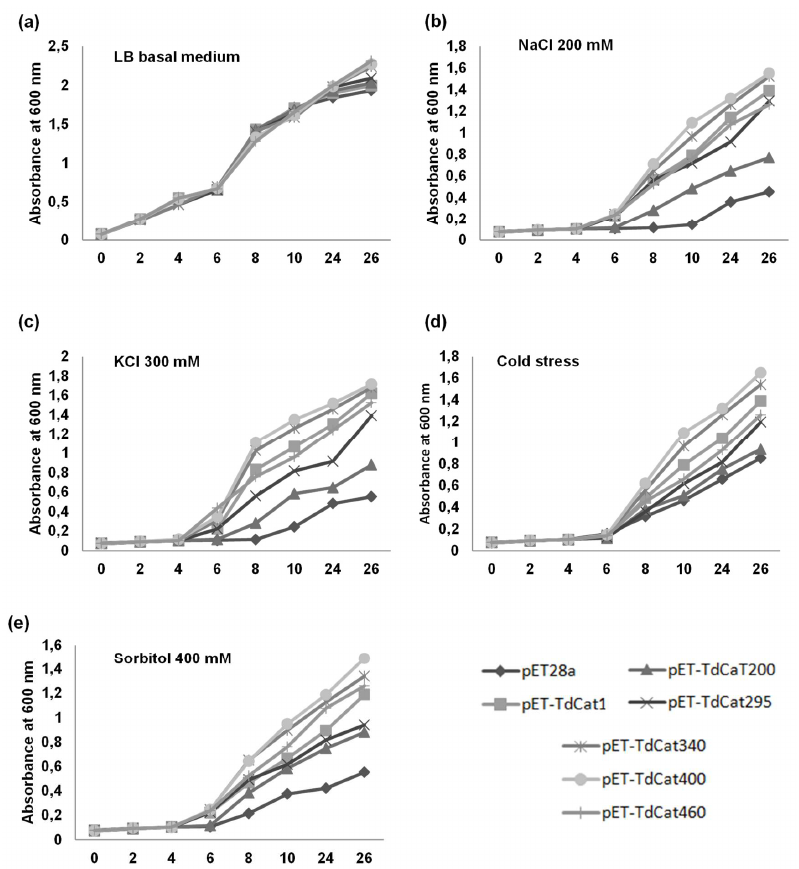
Figure 5. Behavior of TdCAT1 and derivative-forms-transformed bacteria in liquid LB medium in normal conditions ( a ) or in presence of 200 mM NaCl ( b ); 200 mM KCl ( c ) or cold stress (4 °C; d ), or 400 mM Sorbitol ( e ). E. coli cells transformed with the empty vector (pET28a) or with the recombinant vectors (pET28a + TdCAT1 or its derivatives) were grown for 24 h in different medium. Data are means ± SE of three biological replicates.